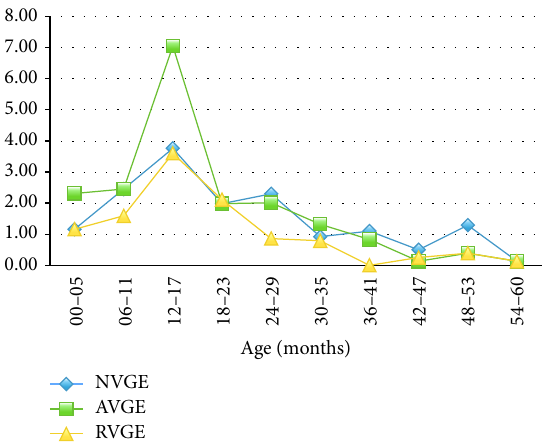
Figure 2: Incidence of AGE by age at onset. Figure 3: Distribution of fever, vomit, and abdominal pain during RVGE episodes stratified by age.